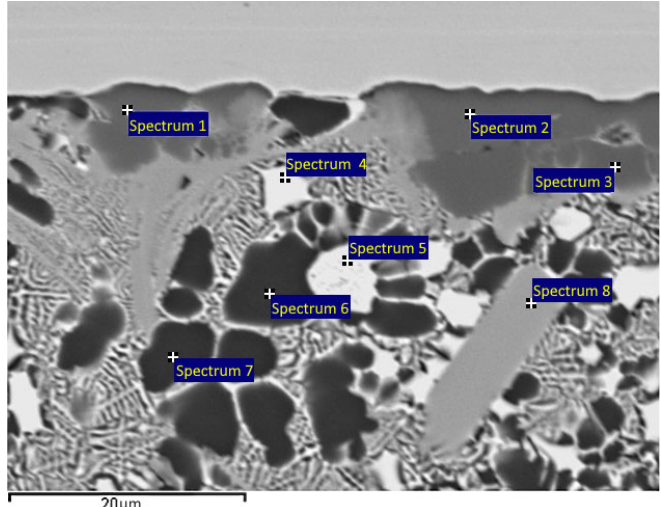
Figure 9. Microstructure of the AISI 304/AISI 304 joint brazed according to the 540 °C/30 min mode, obtained by SEM at 500× magnification.